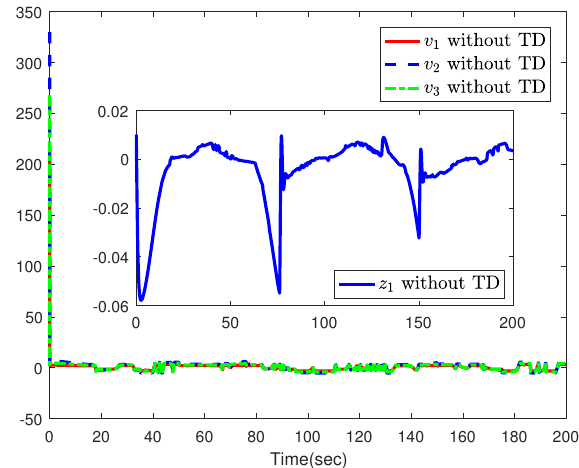
Figure 8. Control effect of System (3) without